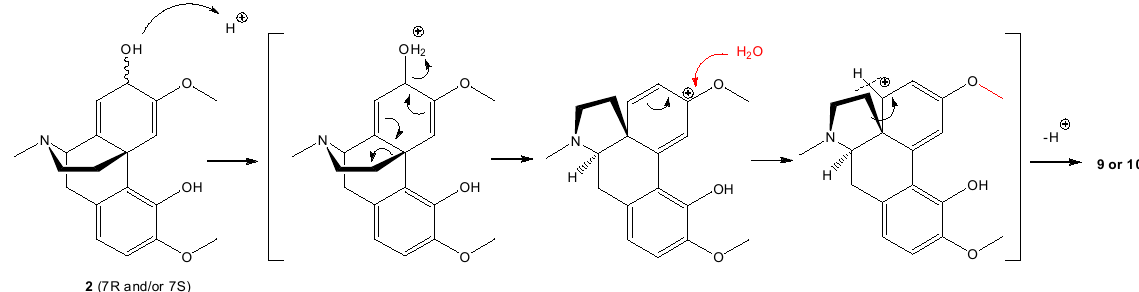
Scheme 7. Suggested mechanism for the rearrangement of salutaridinols 2